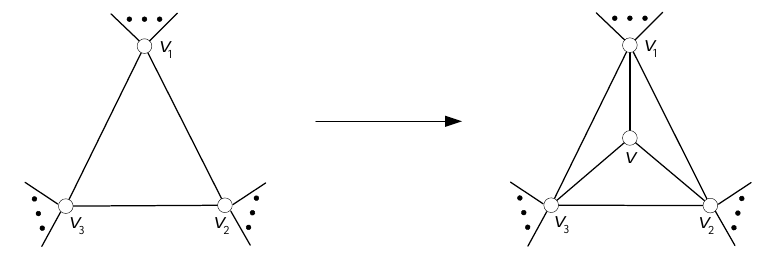
Figure 1. The extending 3-wheel